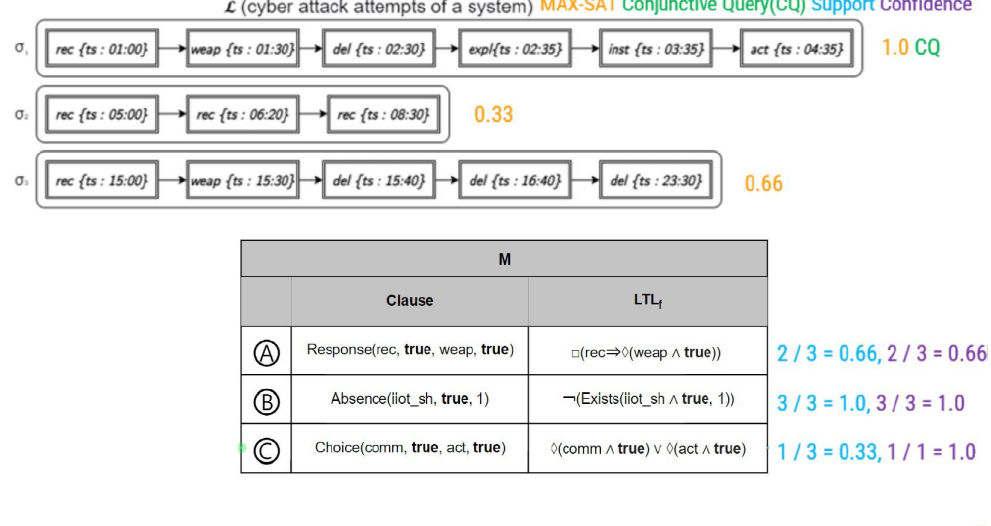
Figure 6. Assessing a high-level use case of an intrusion attack on a software system through a declarative model. Table 6. Conjunctive and Aggregation queries for Figure 6. ( a ) Metric calculations per trace.